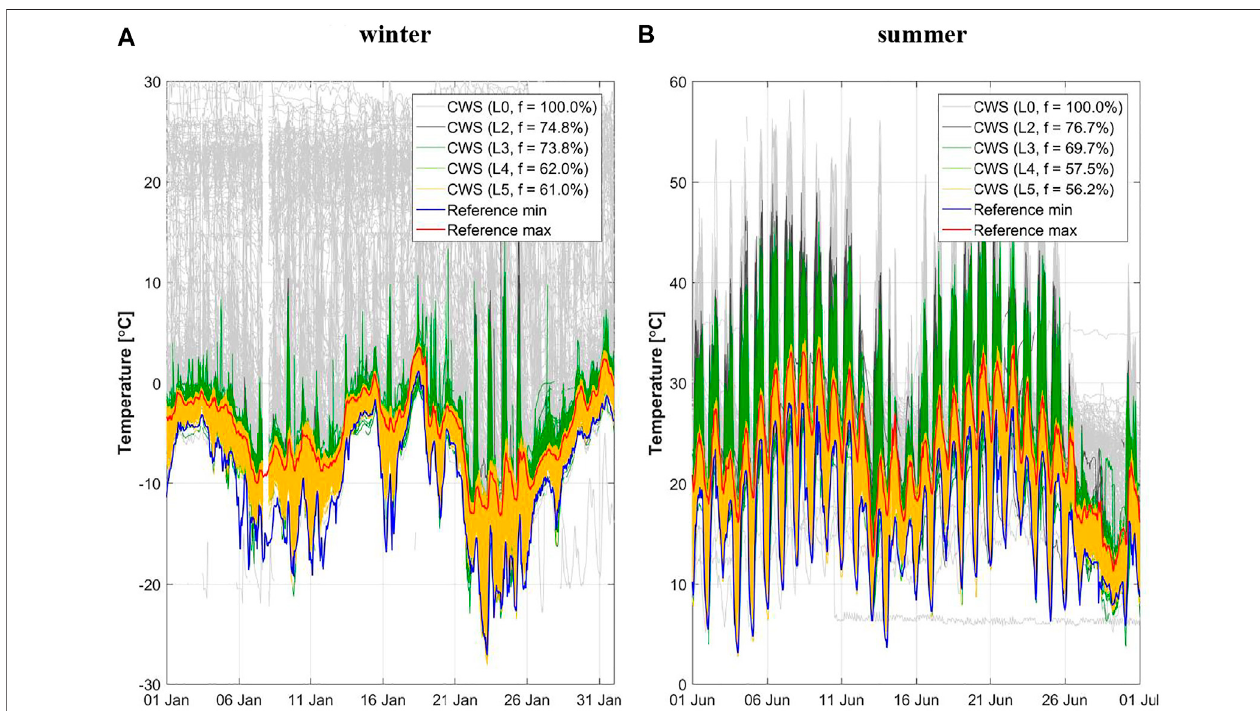
FIGURE 2 | Air temperature in the study region for January 2019 (A) and June 2019 (B) for citizen weather station (CWS) data and reference observations. Quality control (QC) levels L0 – L5 refer to the data after each respective level ofquality control for CWS data. In the legend, f (cid:1) n ( Li ) / n ( L 0 ) indicates the fraction of individual temperature values over all CWSs that passed through the i-th QC level. Reference minimum and maximum were identi fi ed as the respective individual (hourly) values among all reference stations within the study area. Note the different scales of the